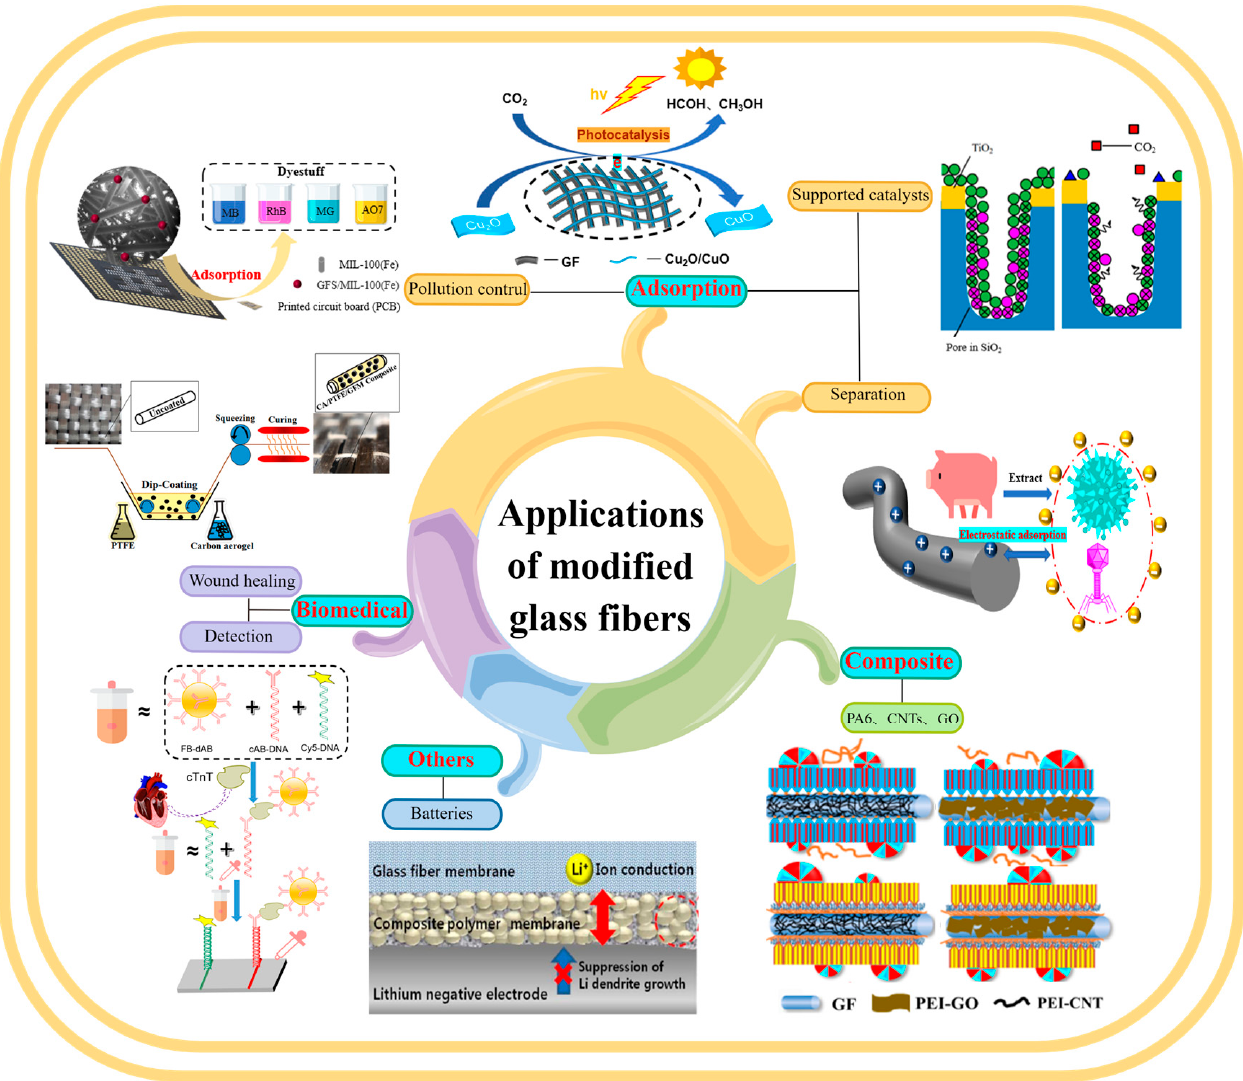
Figure 18. Overview of the application of modified glass fibers diagram (by Figdraw) .